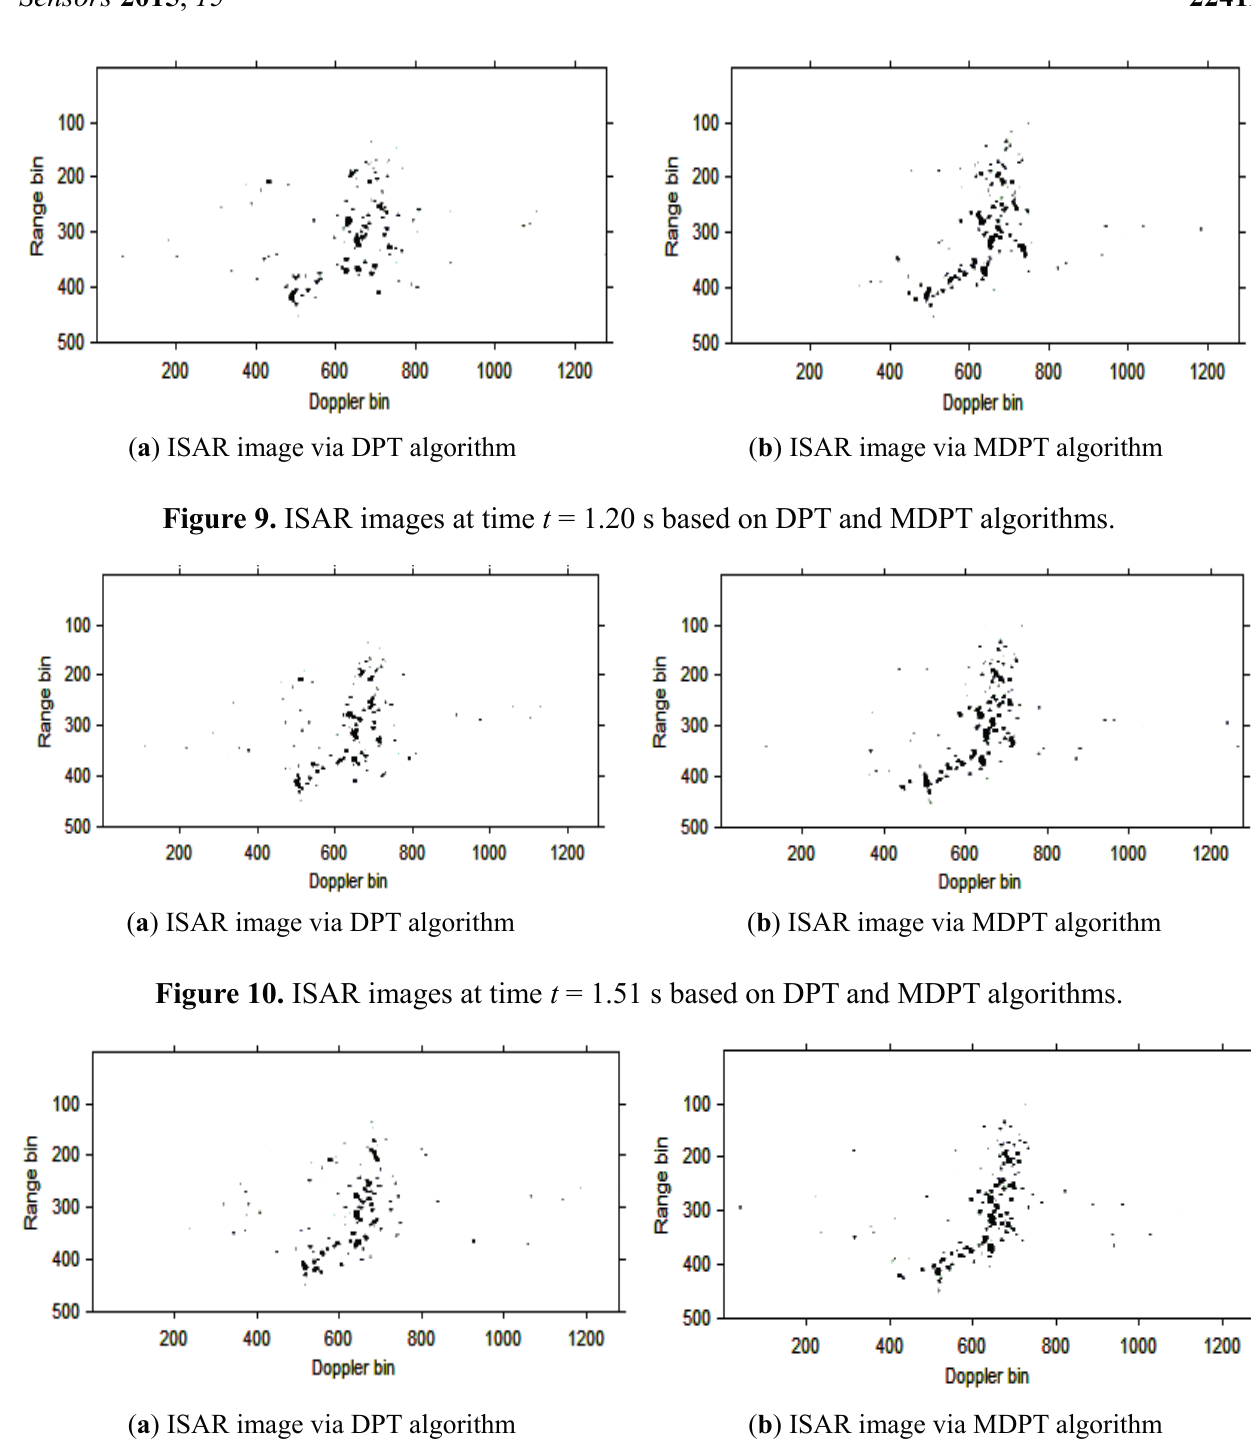
Figure 11. ISAR images at time t = 1.81 s based on DPT and MDPT